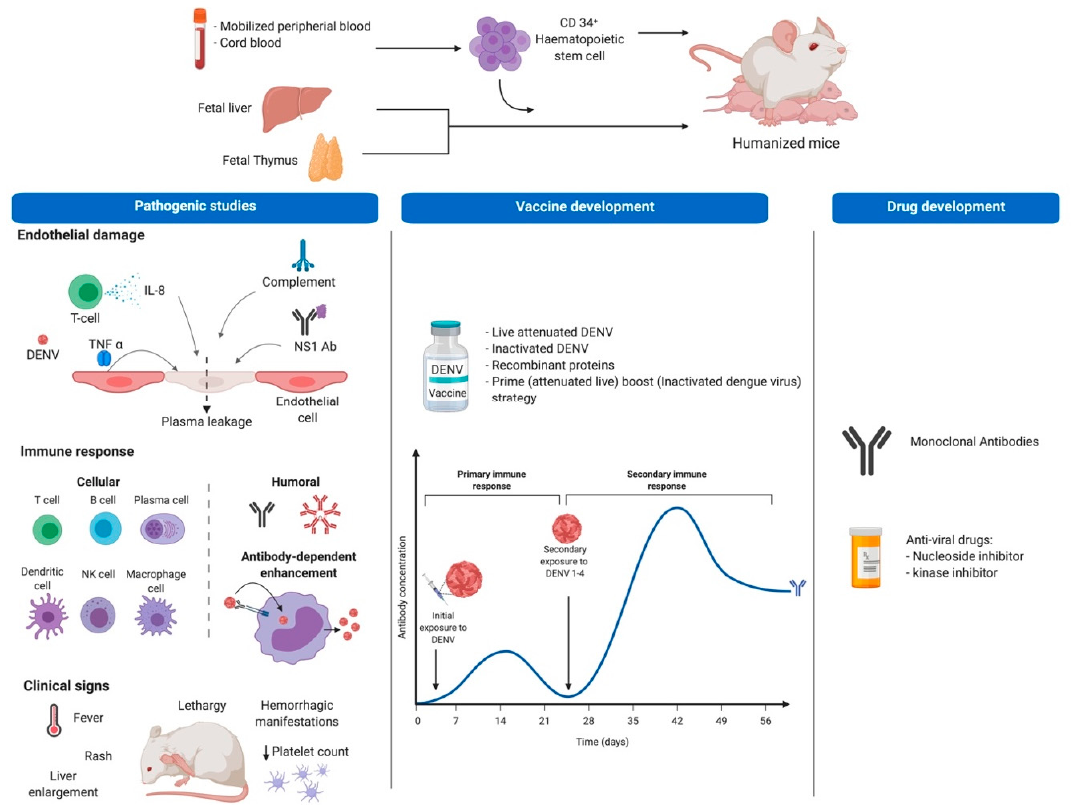
Figure 1. Humanization procedure and potential uses of Hu-mice for dengue studies. Top part shows tissues or organs used for obtention of CD34+ human hematopoietic stem cells (HSC) to be injected in immunodeficient mice. The bottom section shows the potential use of Hu-mice in dengue research including pathogenesis studies as well as vaccine and drug development. For pathogenic studies, researches look for development of DF clinical signs and for the role of some of the immune system components on disease pathogenesis using in vivo models, in this case Hu-mice (first panel). Additionally, Hu-mice allow testing of immunogens with potential use as vaccines protecting against all DENV serotypes (meddle panel), and since they allow viral replication, they are suitable to test compounds with antiviral activity (last panel). This figure was created under a paid subscription from Biorender.com.